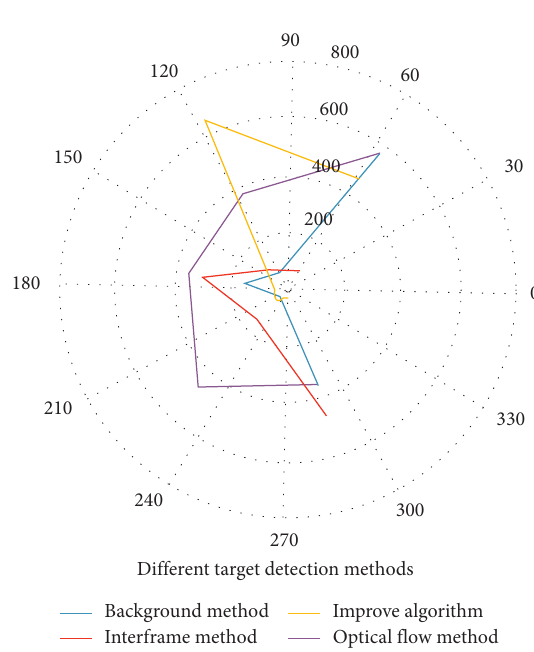
Figure 3: The correctness of different methods.